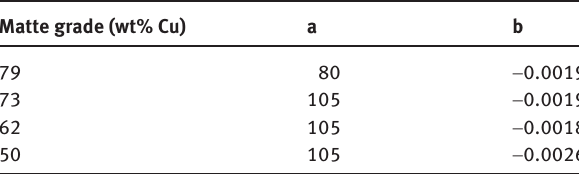
Table 6: The a and b terms (Equation 1) for the lines of best fit to the transportation of lead form copper mattes of varying grade at 1300 °C bubbled with argon at 100 cm 3 .min − 1